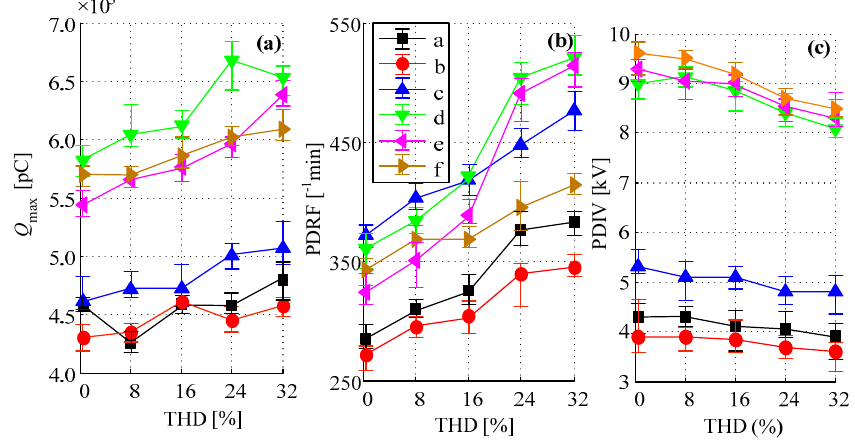
Figure 6. Measured parameters of six PD models under different THD conditions. ( a ) The maximum PD quantity; ( b ) the PD repetitive frequency; and ( c ) the PD inception voltage.